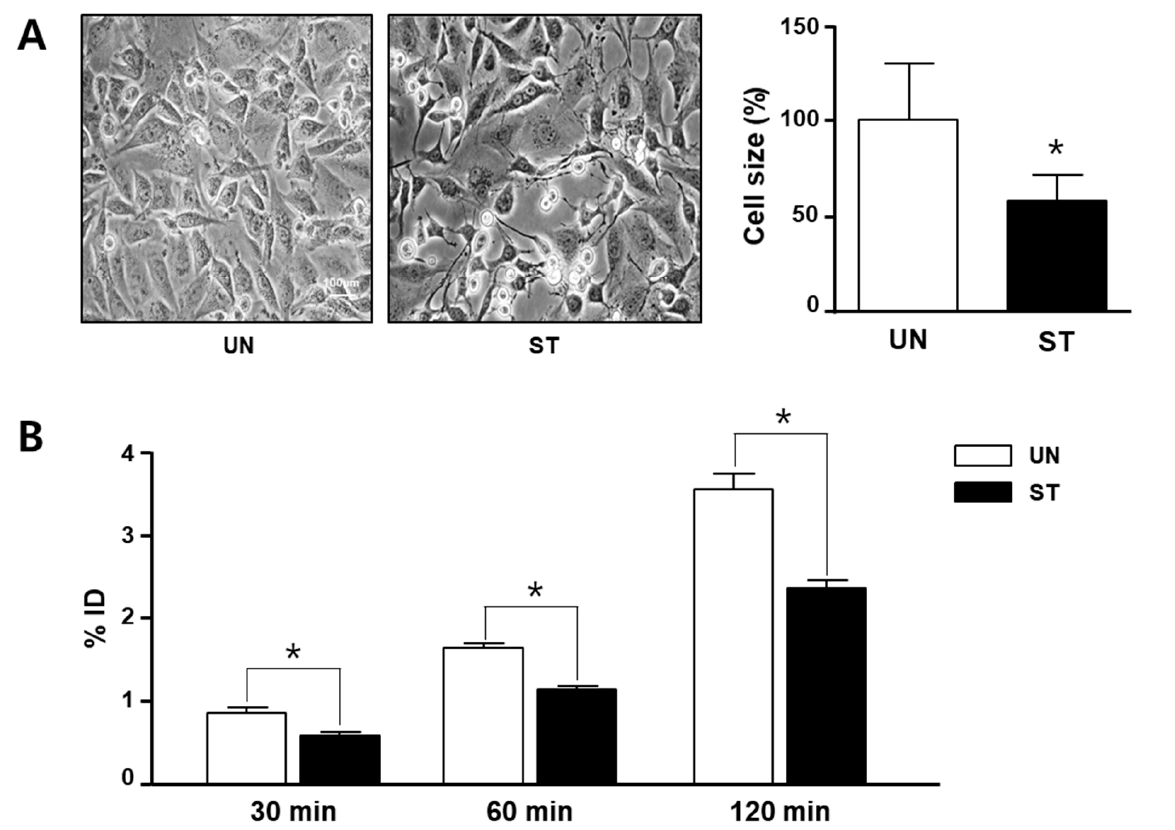
Figure 1. Morphological change and 18 F-fluorocholine (FCH) uptake in the serum-starved rat skeletal muscle (L6) cell. L6 cells (1 × 10 5 cells/well) were seeded in 6-well plates and then incubated in the presence or absence of fetal bovine serum supplemented with Dulbecco’s modified Eagle’s medium for 24 h. ( A ) Cell size was analyzed with bright field microscopy (magnification 100 × , n = 4). The graph indicates the relative cell size from photography. Three random area sizes were analyzed using the ImageJ software. The cell size in the untreated (UN) group is considered 100%. ( B ) L6 cells were incubated with 18 F-FCH for 30, 60, or 120 min ( n = 3). The cells were harvested, and uptake of 18 F-FCH was detected using a gamma counter. The graph is expressed as gamma counter results of the %ID in each condition. All data are expressed as mean ± standard deviation. * p < 0.05 vs. the UN group.